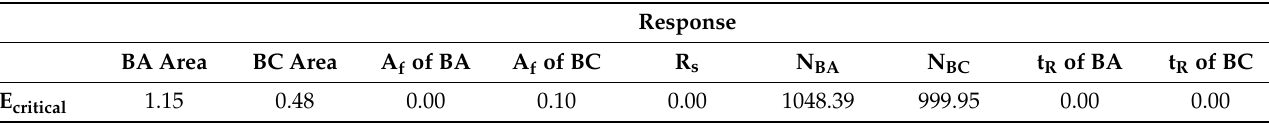
Table 5. E critical values of each one of the experimental